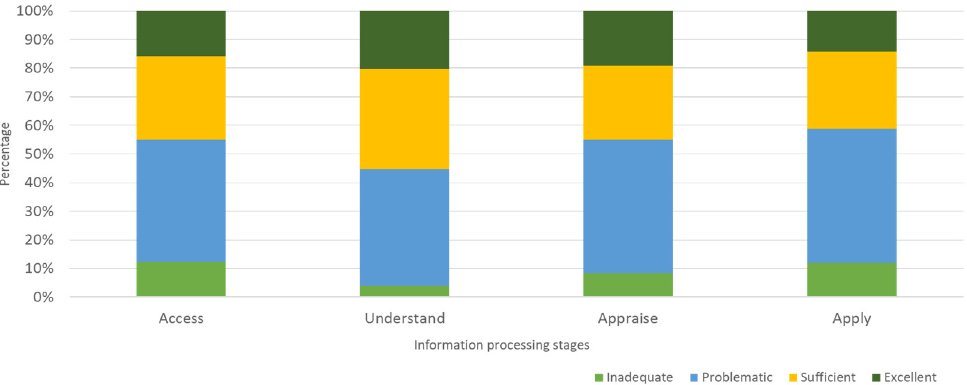
Figure 3. Caregivers’ health literacy distribution by information processing stages/categories (HLS- EU-PT). Table 4. Bivariate statistics—health literacy and sociodemographic factors (short